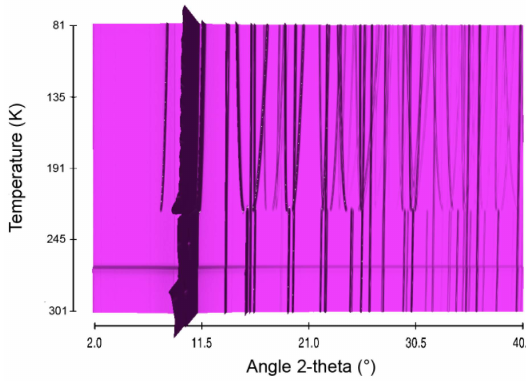
Figure 1. Sequential plot of the diffraction patterns of AB within the range of temperature 81–301 K.